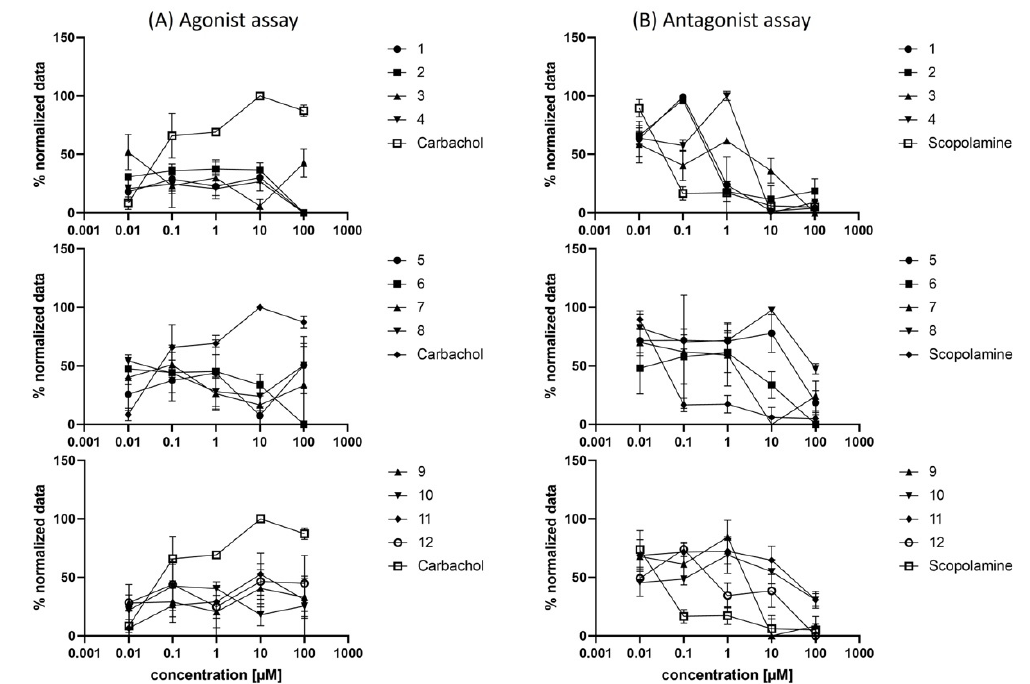
Figure 5. Dose-dependent Ca 2+ mobilization induced by carbamates 1 – 12 in CHO- h M 1 cells. ( A ) Agonist dose-response experiment; ( B ) Antagonist dose-response experiment with the reference agonist carbachol added at a final concentration of 20 µM.